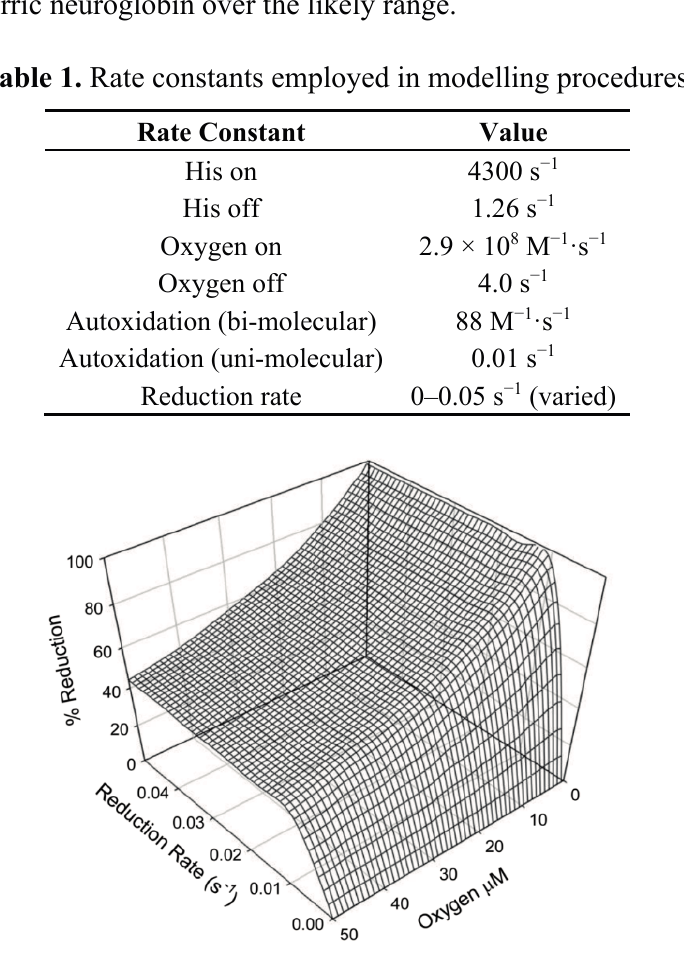
Figure 3. Simulation of the steady state level of ferrous neuroglobin present during redox cycling. The three dimensional surface represents the calculated steady-state level of ferrous neuroglobin present under different conditions of oxygen concentration and reduction rate constant determined from the redox cycling model. The oxygen concentrations plotted in the graph are the initial concentrations, which were maintained throughout the